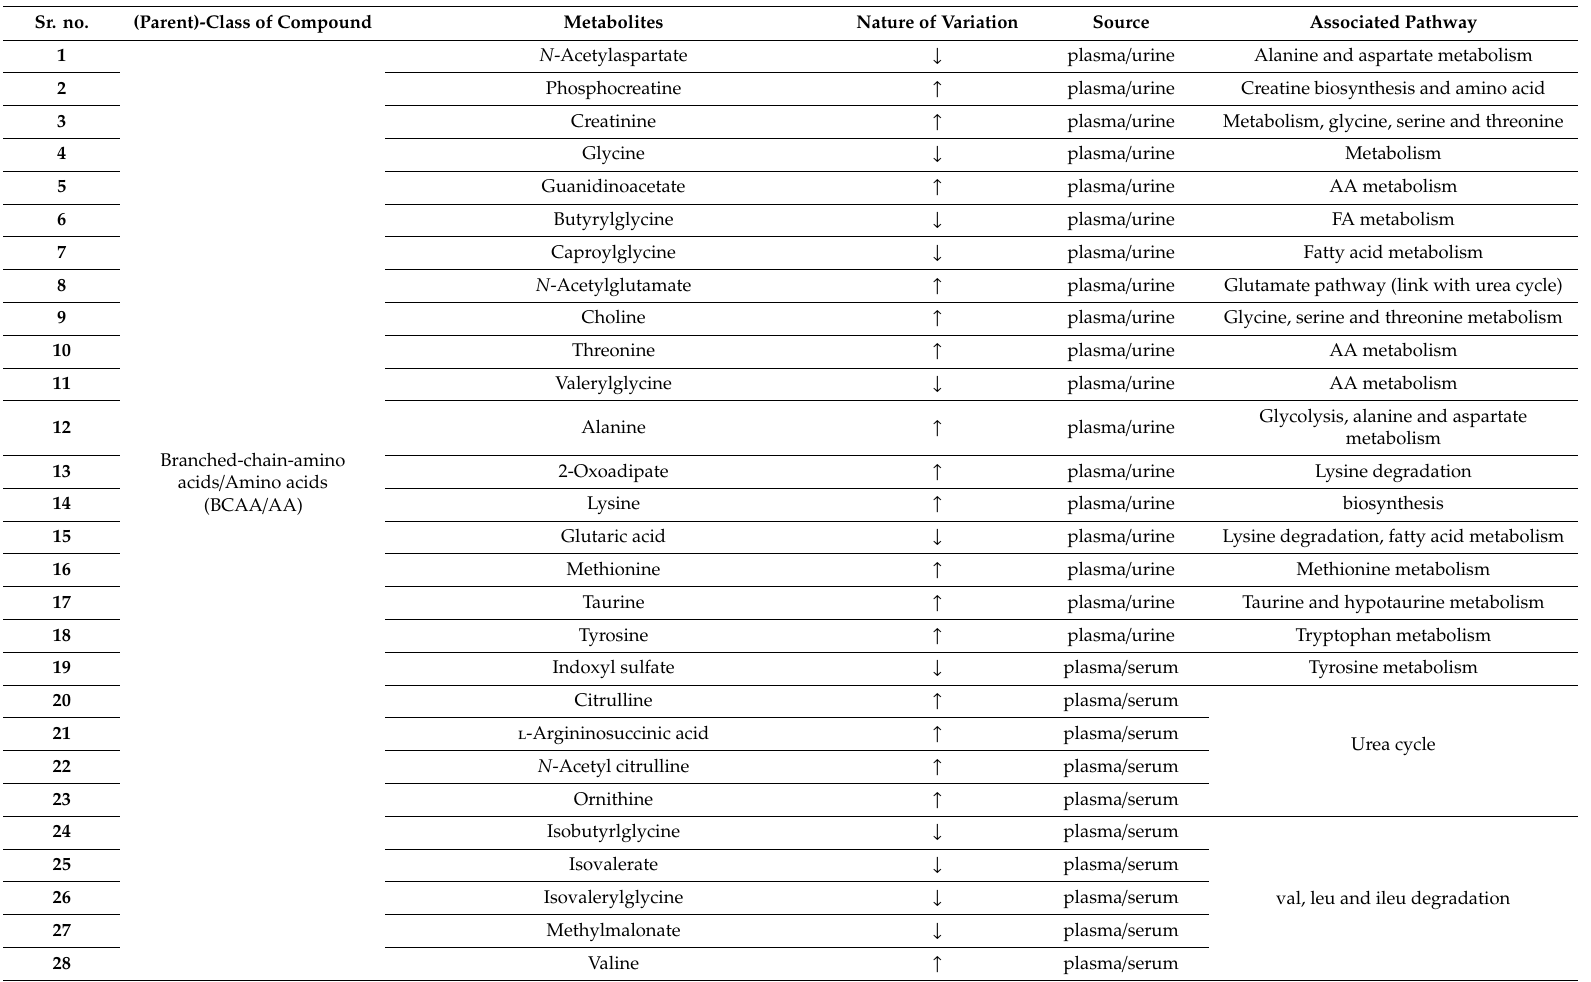
Table 1. A comprehensive list of altered metabolites of lipids and amino acid (AA) origins found in cohort studies mentioned in the respective sections. Sr.